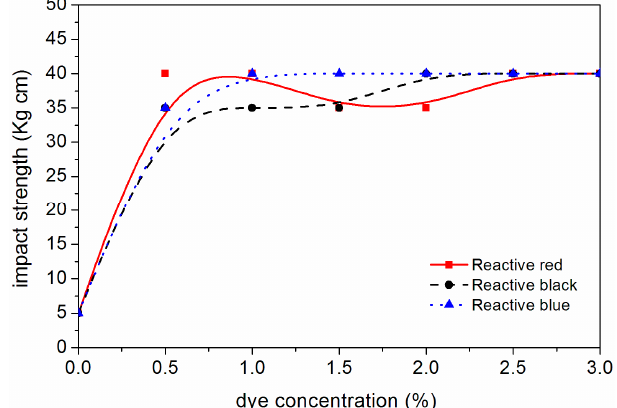
Figure 9. Variation trend of waterborne coating adhesion on the F. mandshurica veneer after dyeing. Polymers 2018 , 10 , x FOR PEER REVIEW